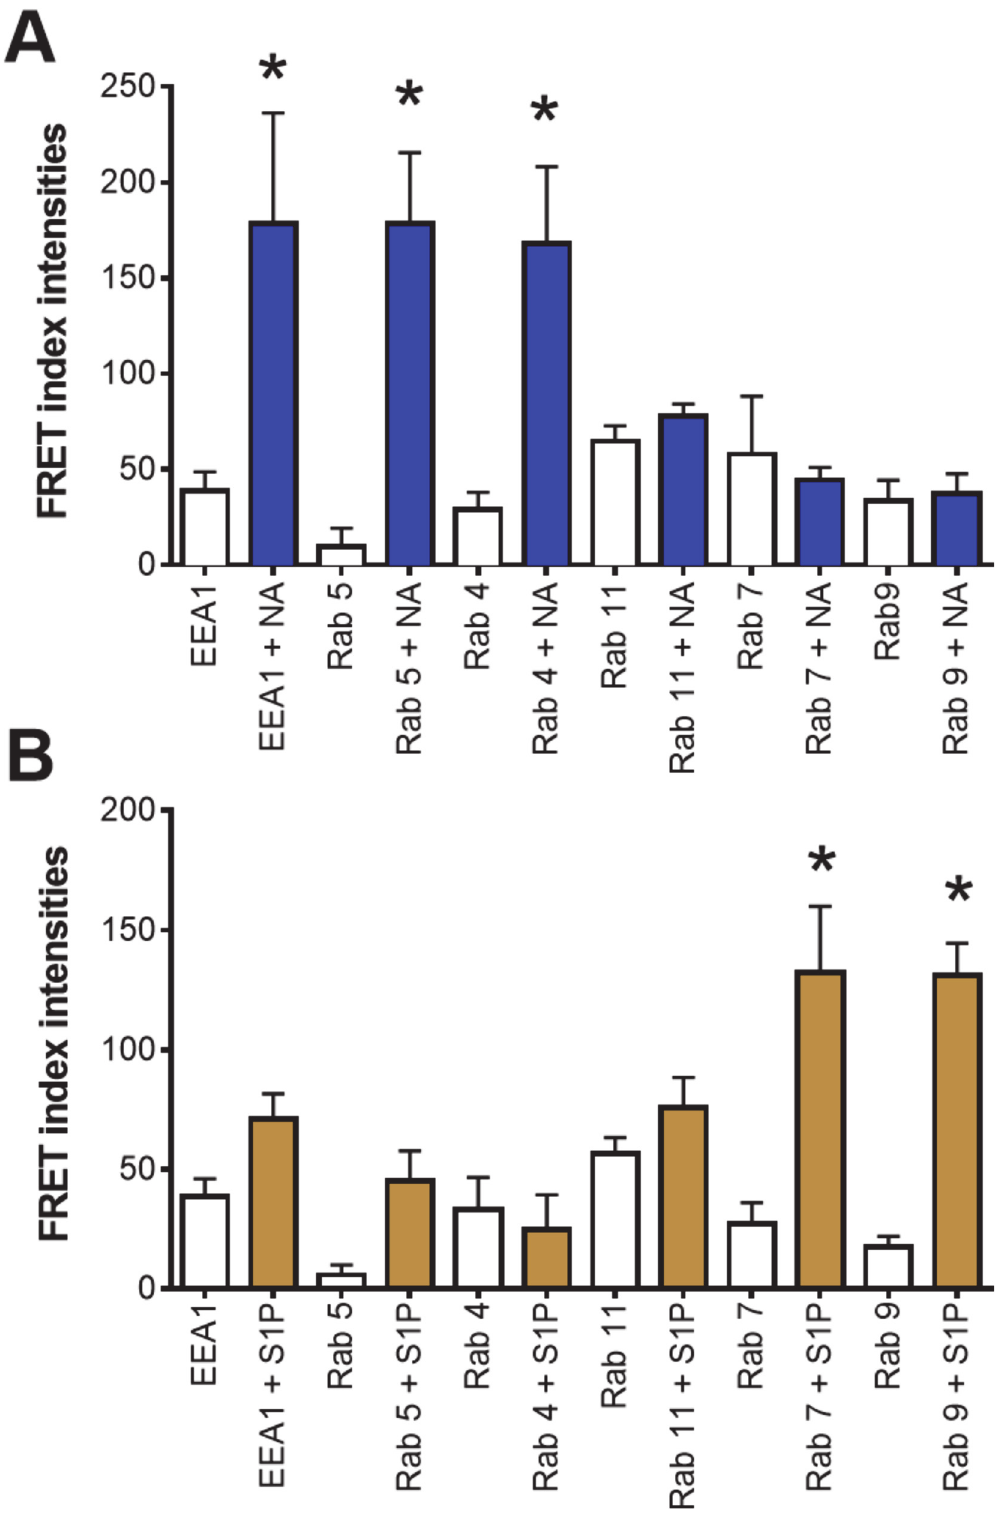
Fig 9. FRET index quantification. Panel A: plotted are the data obtained from cells incubated for 15 min in the absence of any agent (open bars) or with 10 μ M noradrenaline (plus 1 μ M propranolol)(NA, blue bars). Panel B: plotted are the data obtained from cells incubated for 15 min in the absence of any agent (open bars) or with 1 μ M sphingosine 1-phosphate (S1P, brown bars). In the abscissa the protein tagged with EGFP is indicated. Plotted are the means with vertical lines representing the S.E.M. of 5 to 7 determinations using different cell preparations. * p < 0.05 vs. absence of stimuli.